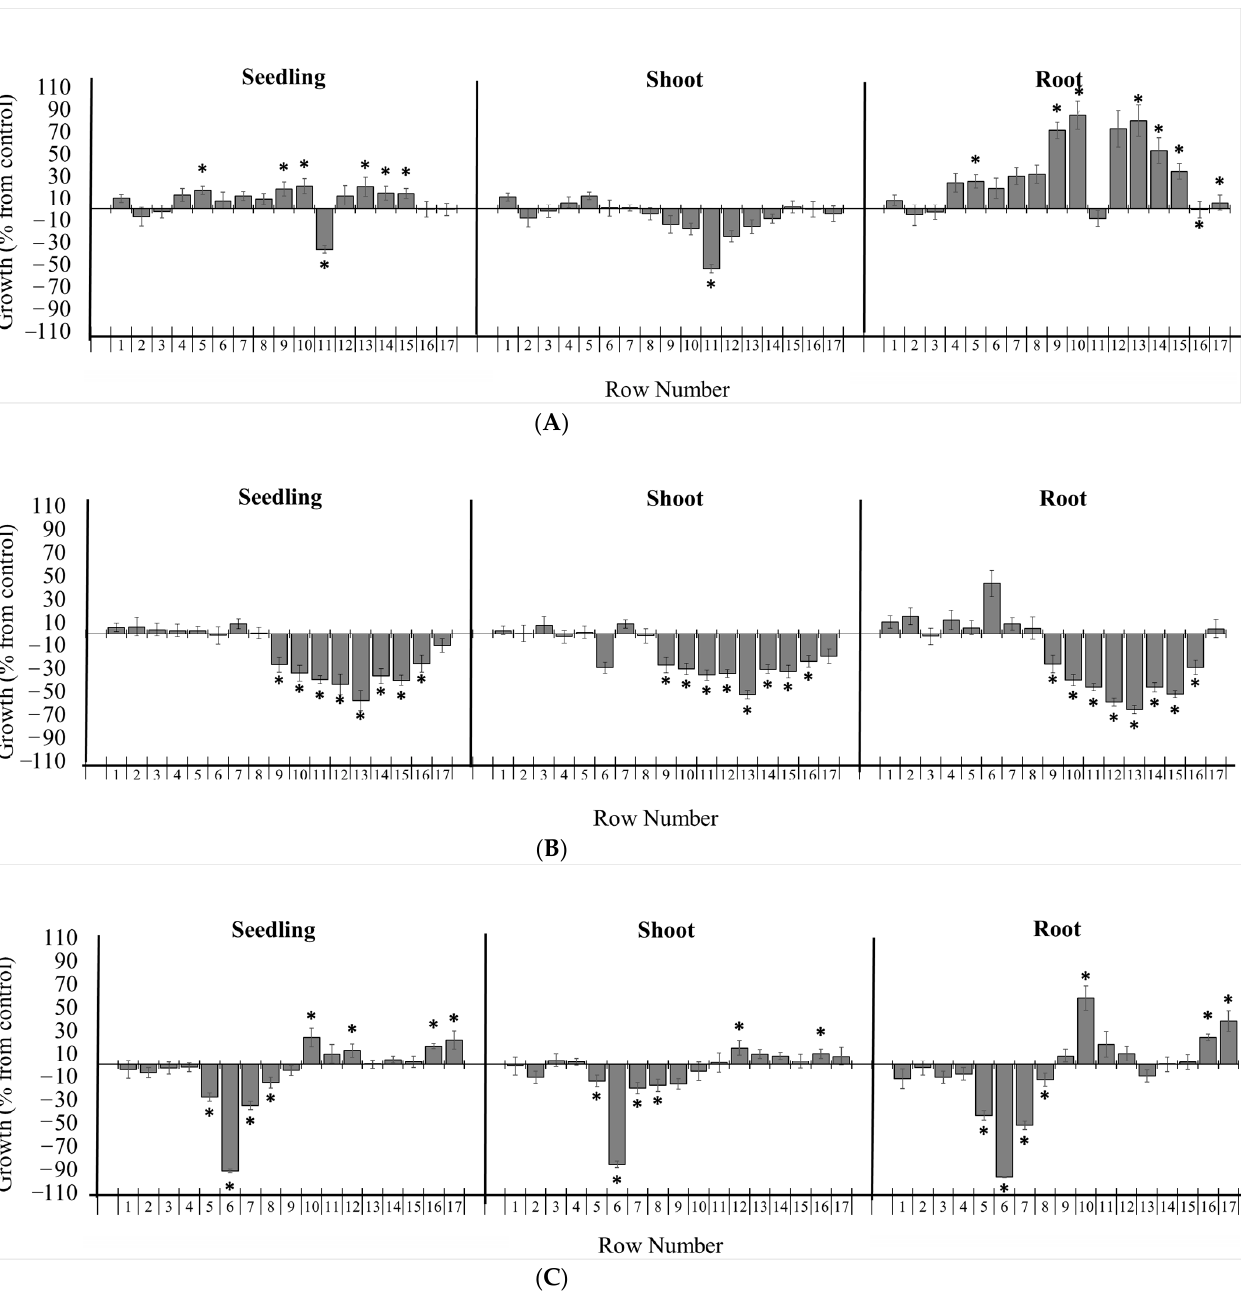
Figure 4. Effects of chromatographic fractions of on the growth of Lactuca sativa . Bioautography assays of ( A ) GVEA, ( B ) HRMEA, and ( C ) POEA extracts on the growth of L. sativa . The bioautog- raphy assay of Gynoxys verrucosa extract revealed dehydroleucodine as the major inhibitory com- ponent (row 11). The bioautography assay of Hedyosmum racemosum extract revealed onoseriolide as the major inhibitory component (row 13). The bioautography assay of Picradeniopsis oppositifolia extract revealed eucannabinolide as the major inhibitory component (row 6). Growth is expressed as the % difference from the control, and the chromatographic bands were divided by 1 cm rows from the application point to the elution limit on the TLC plate (1–17). * Significance is indicated at p (cid:3409) 0.05. All data are presented as the mean ±SEM.